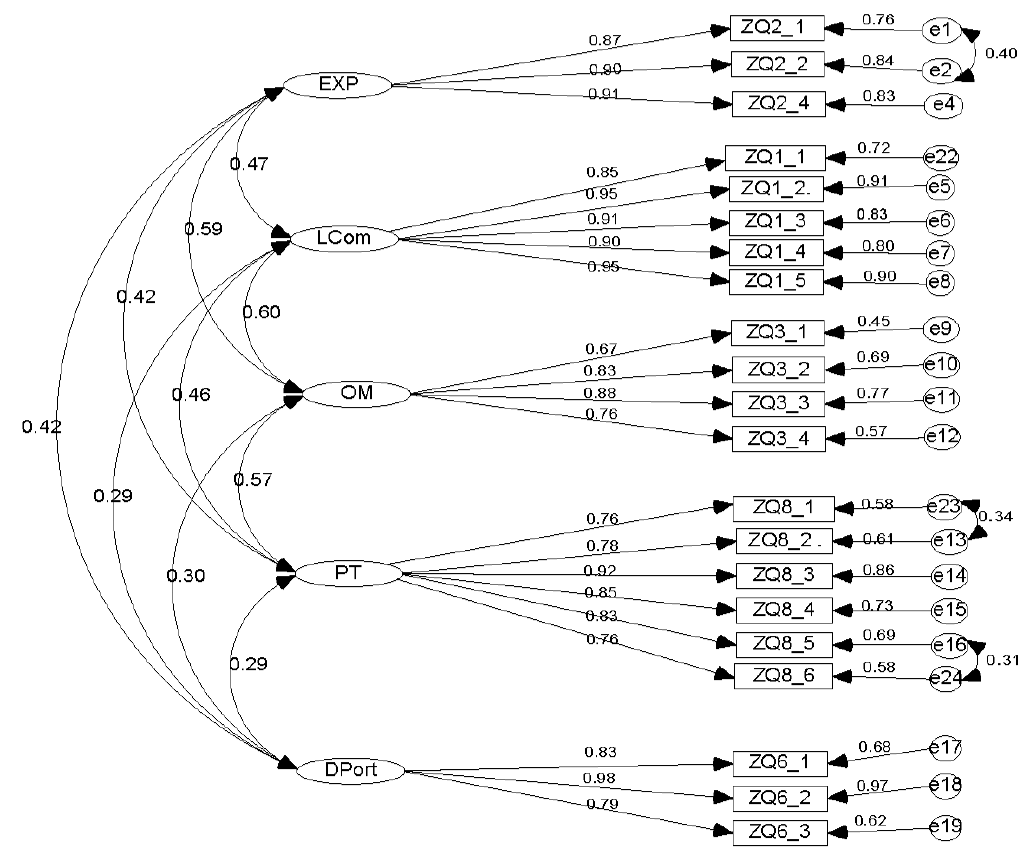
Figure A1. Confirmatory Factor Analysis